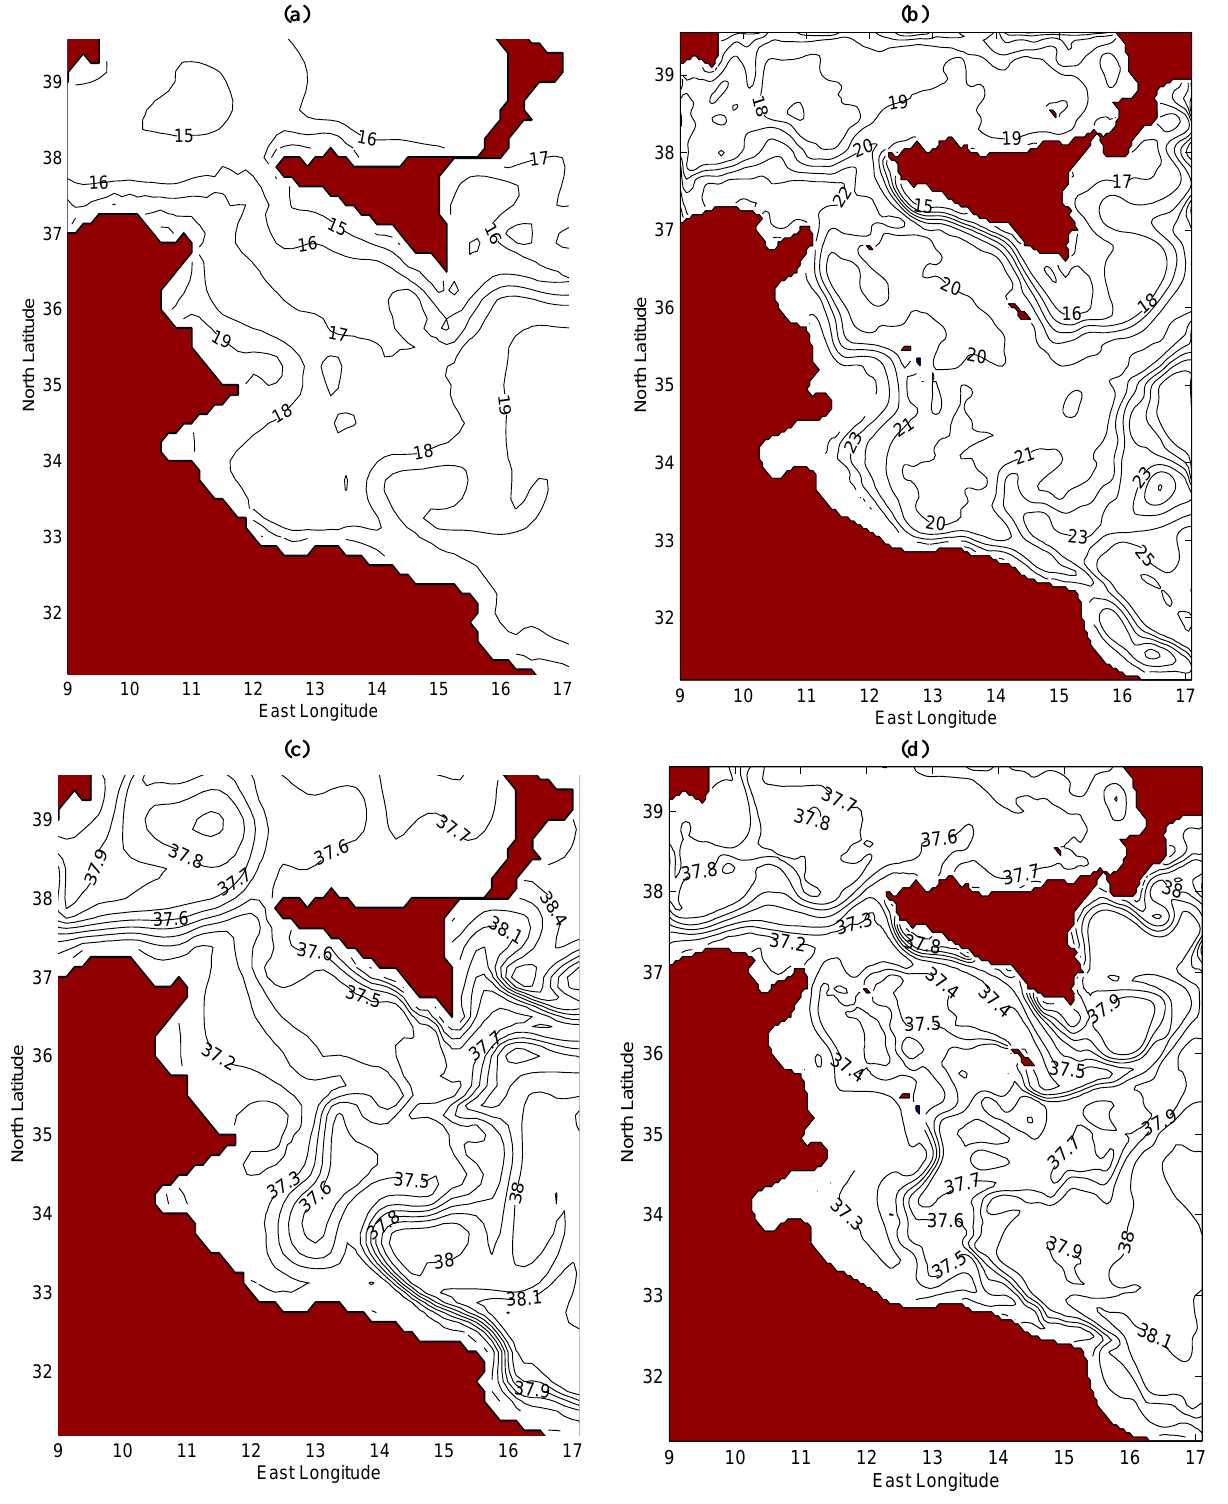
Fig. 10. Comparison of the simulated coarse outer model ( (a) , (c) , (e) ) and the fine inner model ( (b) , (d) , (f) ) using 10-day averaged temperature (a, b), salinity (c, d) and total velocity (e, f) horizontal fields at 30m depth in August (Fig. 10